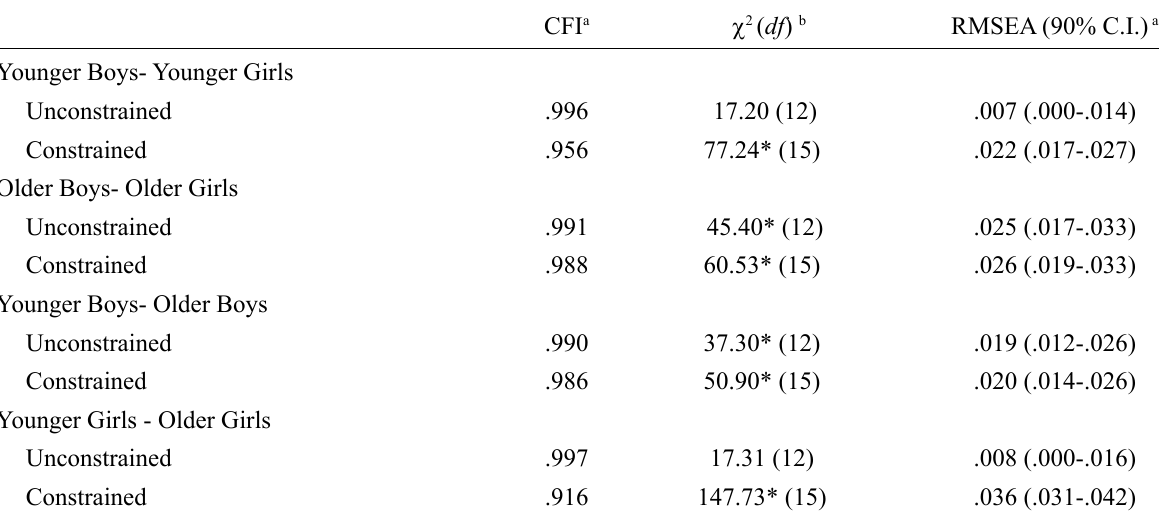
Dependent Measurement Model Fit Indexes (Two by Two Comparisons)